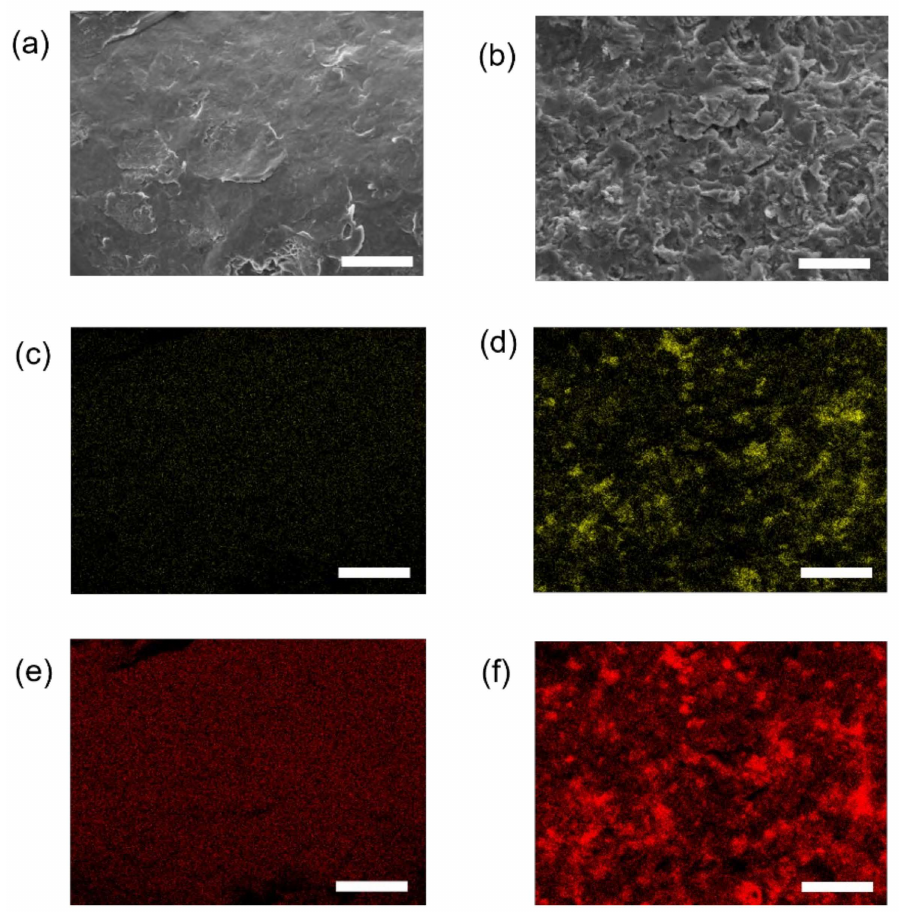
Figure 4. Images of specimen surfaces using electron microscopy with ( a ) no treatment and ( b ) alu- mina sandblast treatment. The specimen surfaces with alumina sandblast treatment were rough in comparison to those with no treatment. Images of oxygen elements on the surface of specimens ( c ) with no treatment and ( d ) with sandblast treatment. The yellow area indicates the presence of oxygen elements. Images of aluminum elements on the surface of specimens ( e ) with no treatment and ( f ) with sandblast treatment. The red area indicates the presence of aluminum elements. The attachment of oxygen and aluminum elements on the surface with alumina sandblast treatment are clearly shown. Bars = 25 µ